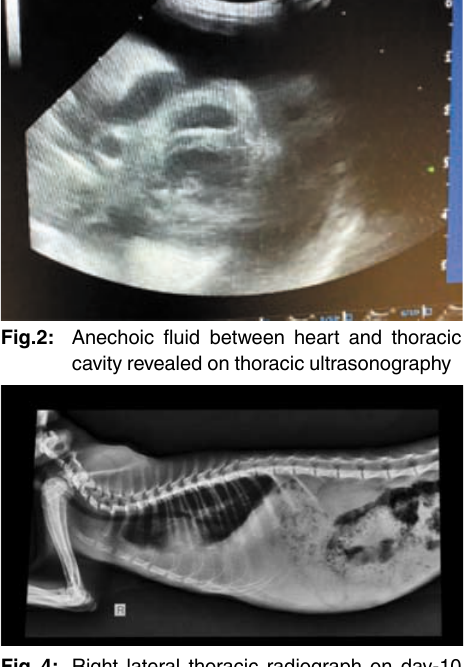
Fig. 4: Right lateral thoracic radiograph on day-10 showing a significant reduction in pleural